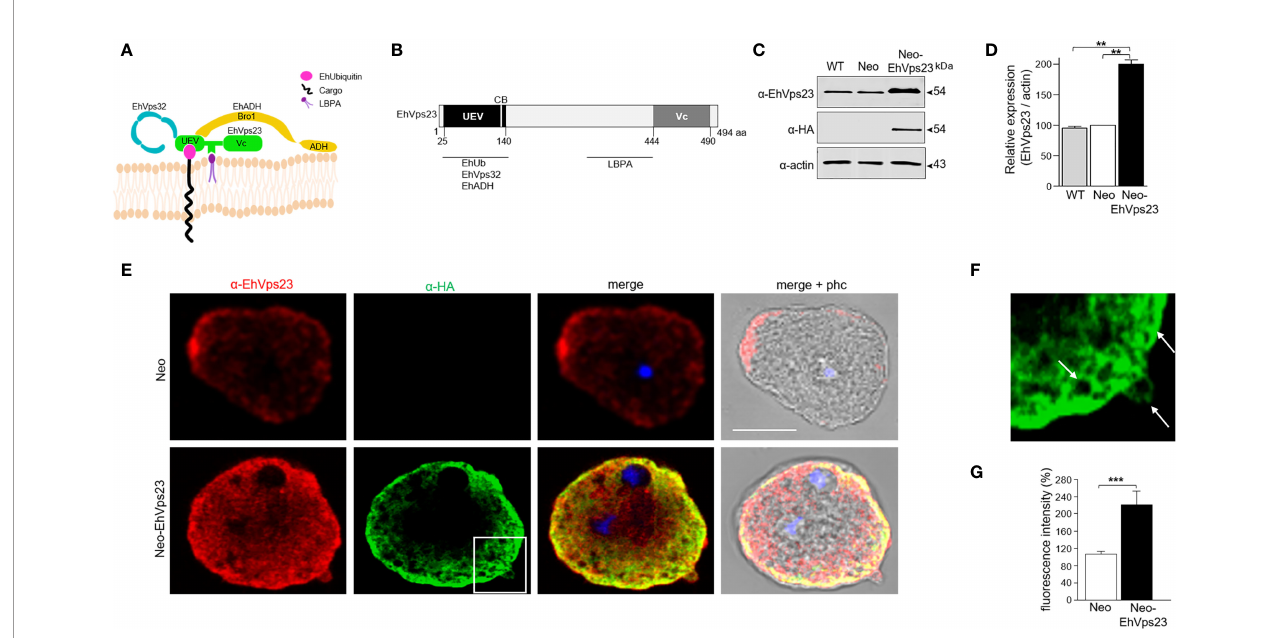
FIGURE 1 | Generation of trophozoites overexpressing the EhVps23 protein. (A) Scheme of EhVps23 in the endosomal membrane and its binding to different molecules. (B) EhVps23 domains. The molecules that EhVps23 interacts with are marked below the annotated number of amino acid in the respective domains. (C) Western blot of extracts from trophozoites of: (WT) wild type strain (HM1:IMSS), Neo: transfected with the empty pNeo plasmid, Neo-EhVps23: transfected with the pNeoEhvps23 plasmid, separated by 10% SDS-PAGE and blotted with a -EhVps23, or a -HA, or a -actin antibodies. (D) Densitometry of three independent western blots. (E) Confocal microscopy image of Neo-EhVps23 and Neo trophozoites using a -EhVps23 and a -HA antibodies. Scale bar = 10 m m. The squared area is magni fi ed in (F) . Arrows: vesicles labeled by the protein. (G) Quanti fi cation of the fl uorescence by pixel counting. ** P < 0.01, ***P <